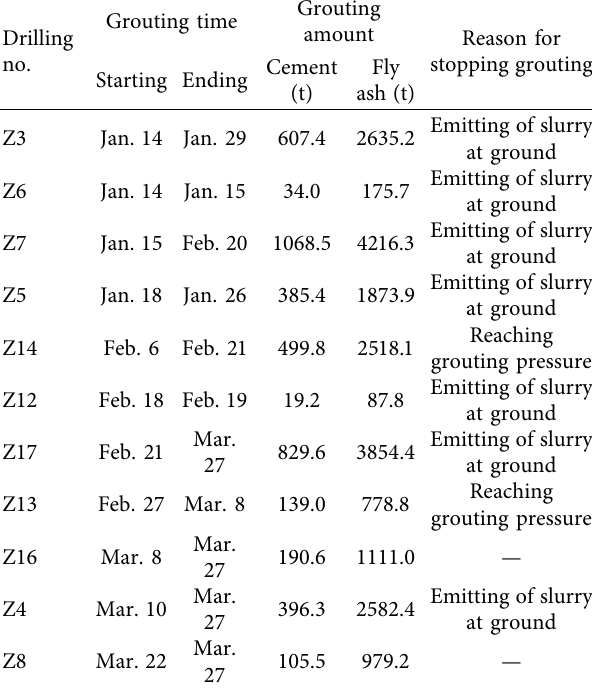
Table 5: Parameters of grouting boreholes.